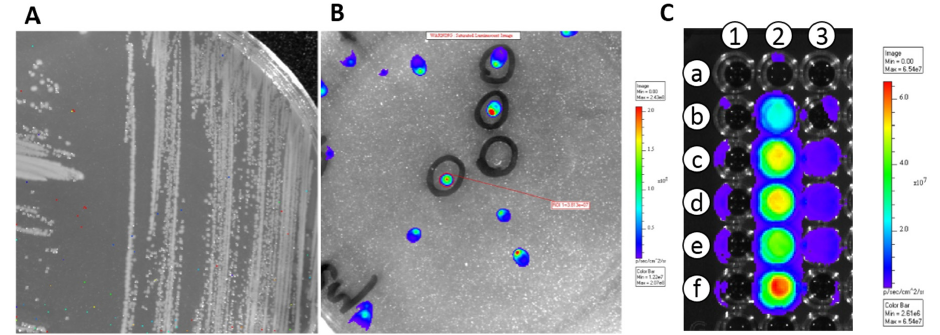
Figure 1. Transformation of E. coli with the lux operon. ( A ) LB agar plate showing non ‐ transformed E. coli cells (negative control). ( B ) LB agar plate showing E. coli cells transformed with pMG36e:: luxABCDE . ( C ) Microtiter plate showing E. coli cells transformed with pMG36e:: luxABCDE ; Column 1: non ‐ inoculated LB medium (negative control); Column 2: files b to f: serial dilutions of E. coli cells transformed with pMG36e:: luxABCDE .